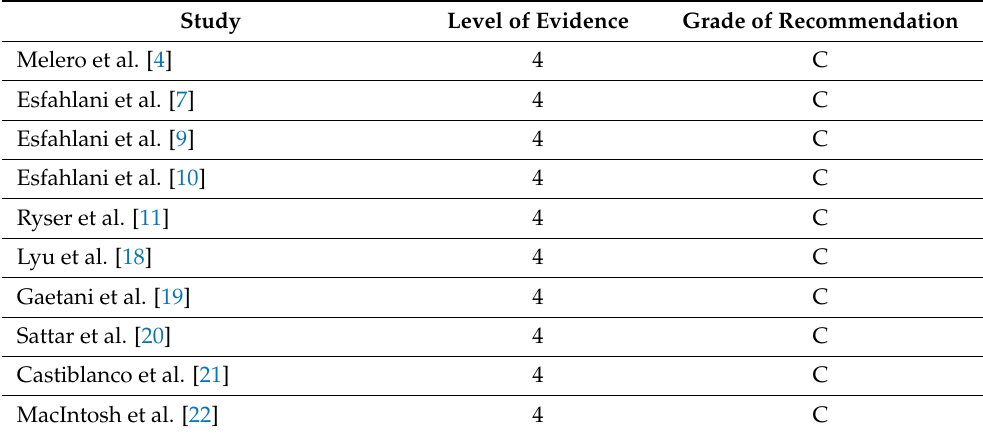
Table 5. Levels of evidence and grades of recommendation established by the Oxford Center for Evidence-based Medicine.